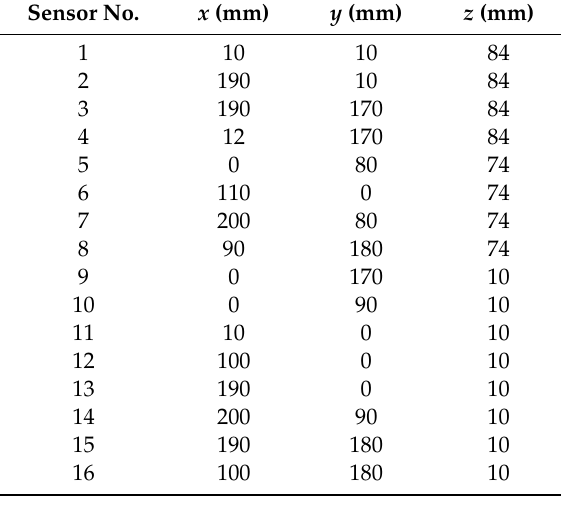
Figure 3. The layout of the AE sensors and sources in the pencil lead break experiment.